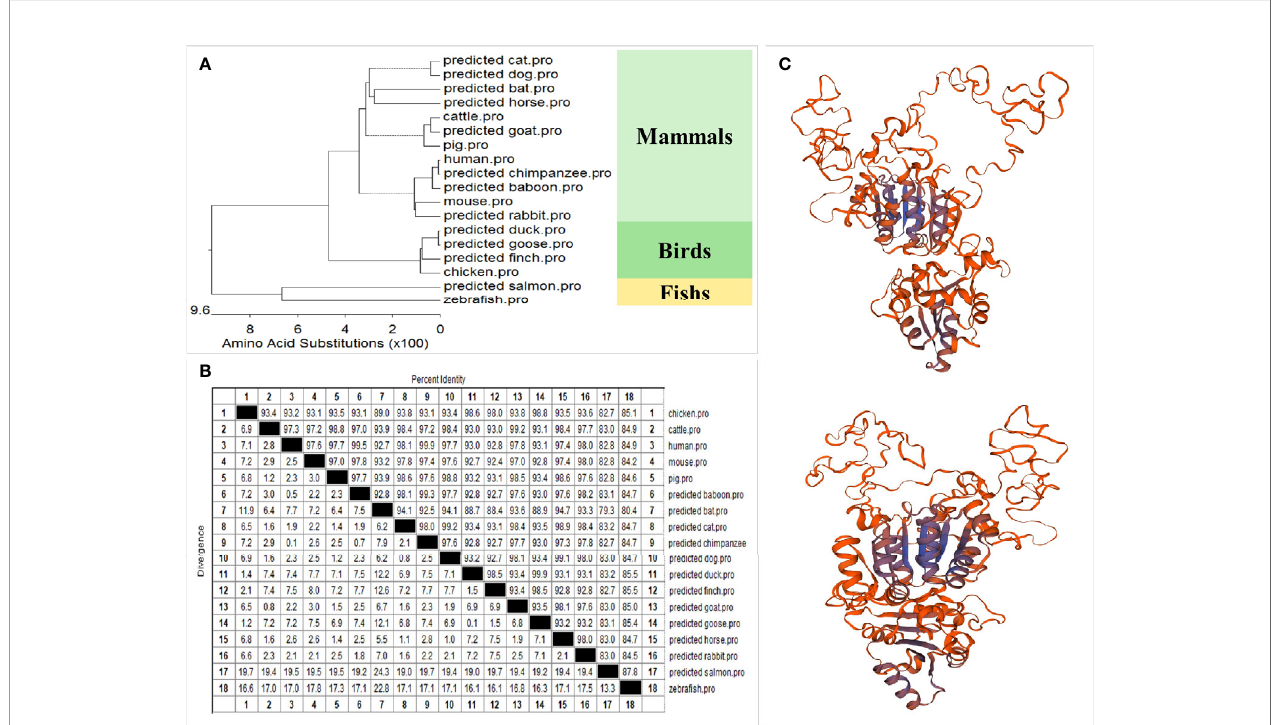
FIGURE 2 | (A) Phylogenetic tree of vertebrate DDX1. A neighbor-joining phylogenetic tree of vertebrate DDX1 was generated with MegAlign software using DDX1 sequences from the following animals: chickens (NP_989894.1_1), cattle (NP_001068936.1), humans (NP_004930.1), mice (NP_598801.1), pigs (ANR02618.1), baboons (predicted, XP_021780285.1), bats (predicted, XP_023384316.1), cats (predicted, XP_011279621.1), chimpanzees (predicted, XP_001162067.2), dogs (predicted, XP_848865.1), ducks (predicted, XP_027311055.1), fi nches (predicted, XP_021381054.1), goats (predicted, XP_017911108.1), geese (predicted, XP_013028107.1), horses (predicted, XP_001502097.3), rabbits (predicted, XP_002710081.1), salmon (predicted, XP_014061742.1), and zebra fi sh (NP_001184253.1). (B) The amino acid sequence homology of different animals. (C) Three-dimensional structure of chDDX1 predicted by